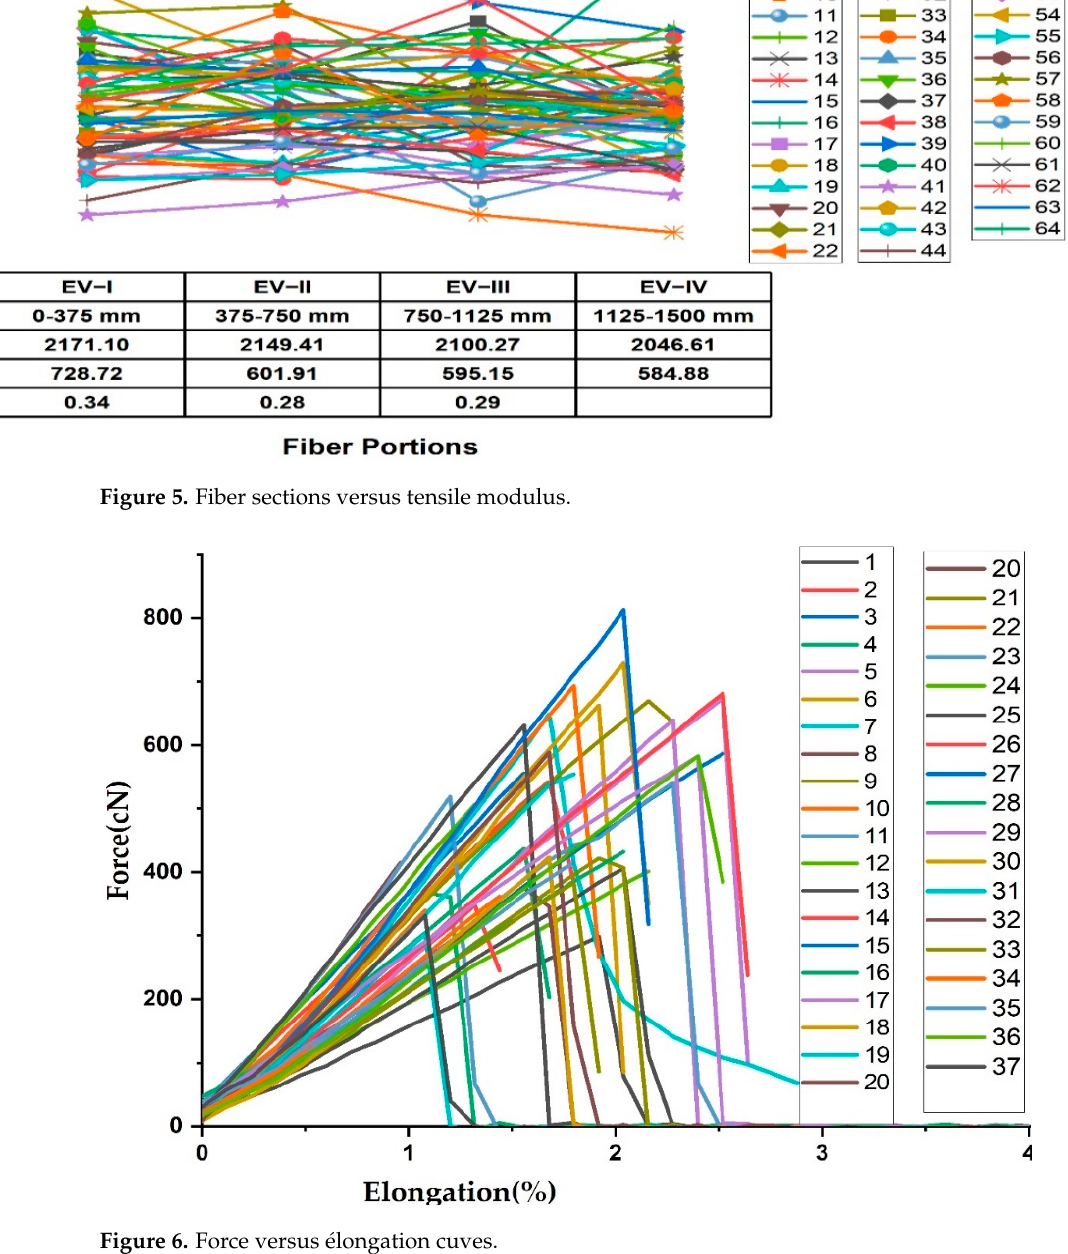
Figure 5. Fiber sections versus tensile modulus.